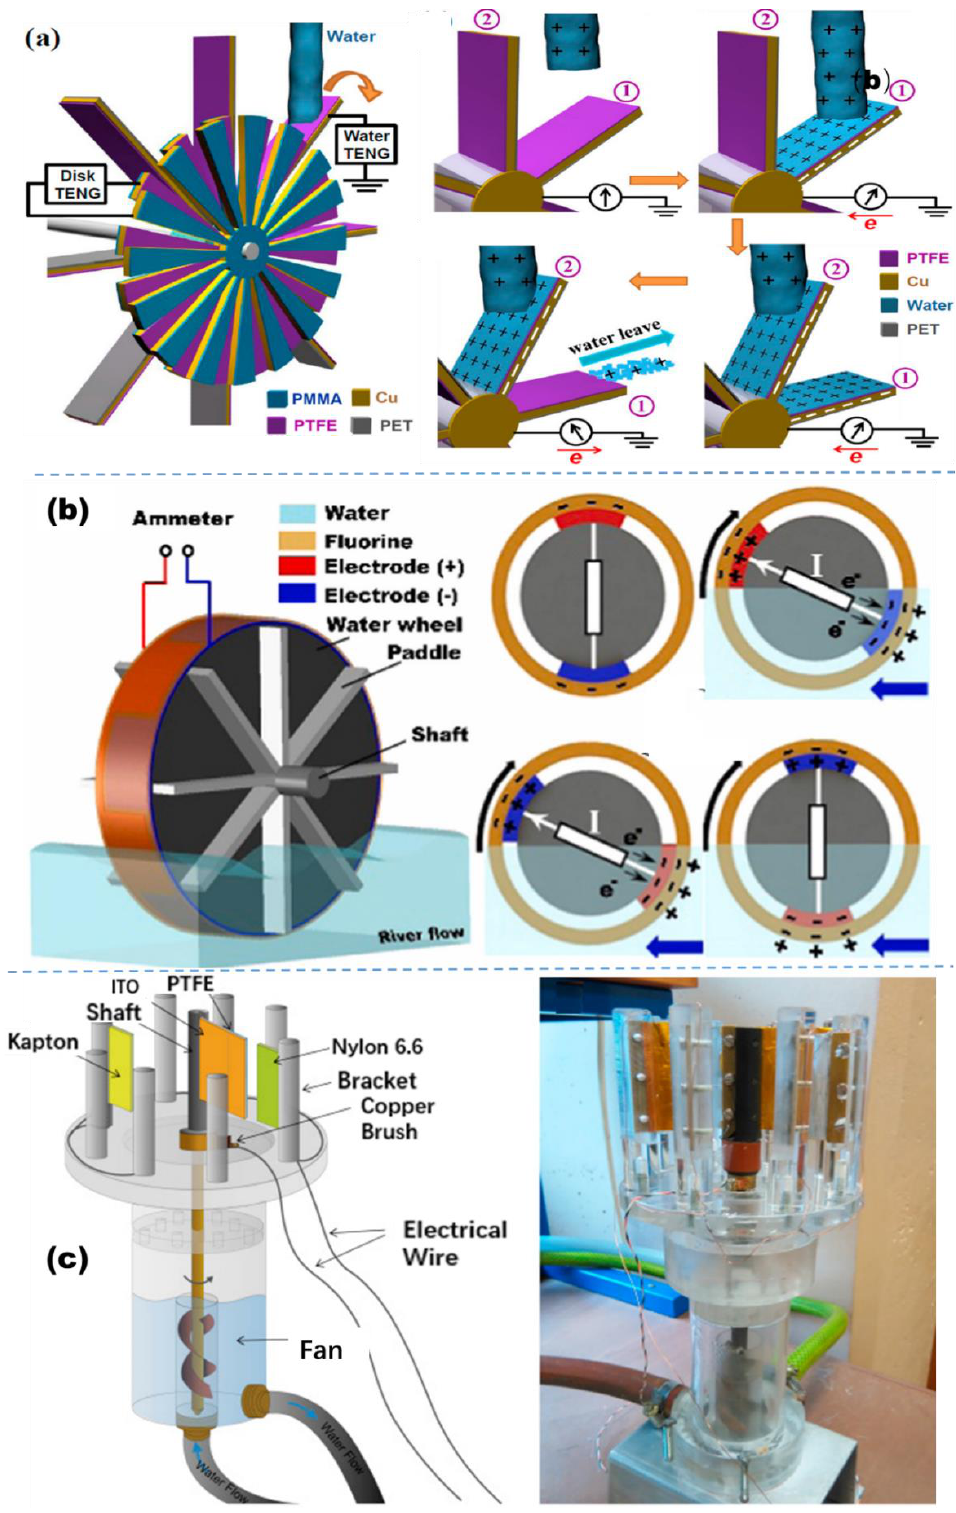
Figure 9. ( a ) The structure of the hybridized TENG (reproduced with permission from [112] Copyright 2014, American Chemical Society, New York, NY, USA). ( b ) Schematic and working principle of the w-TENG (reproduced with permission from [148]. Copyright 2019, Elsevier Ltd., Singapore). ( c ) Schematic diagram of the rotary TENG (reproduced with permission from [54]. Copyright 2016, Elsevier Ltd., Singapore).